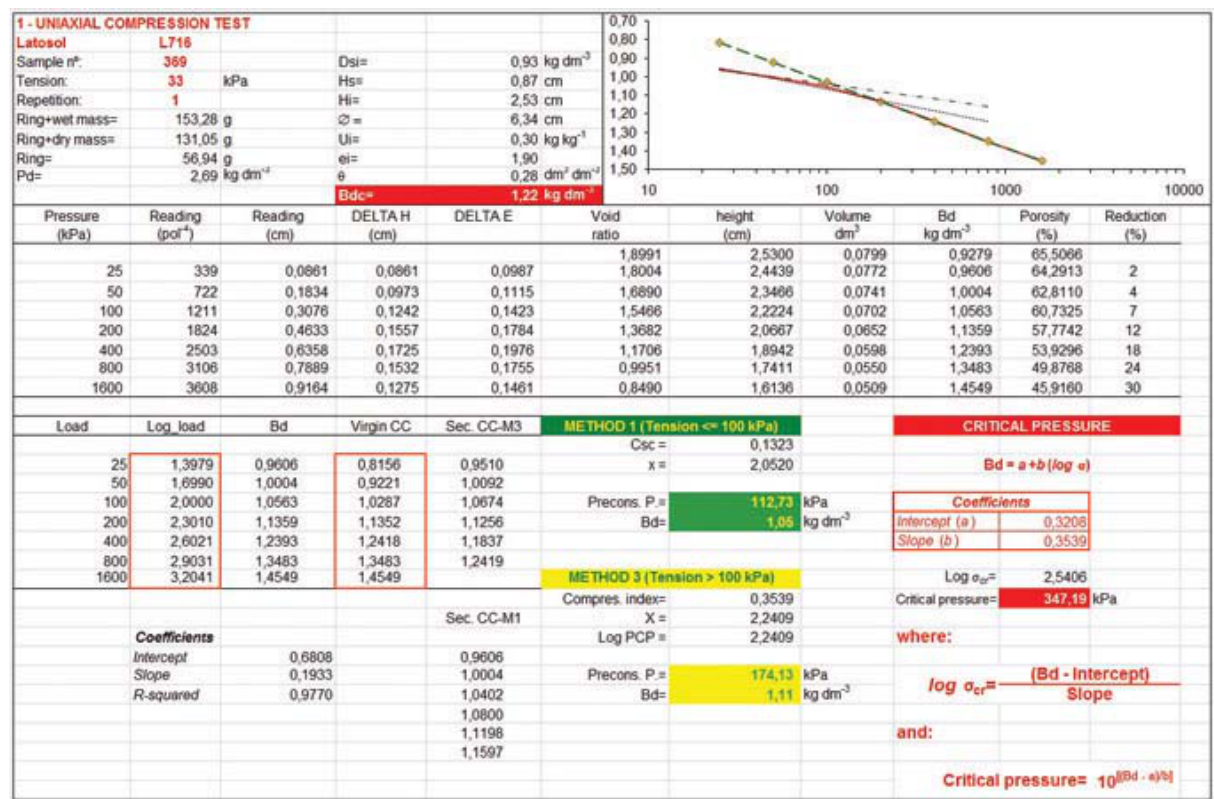
Figure 2. Free flow chart used to estimate preconsolidation pressure, beneficial pressure and critical